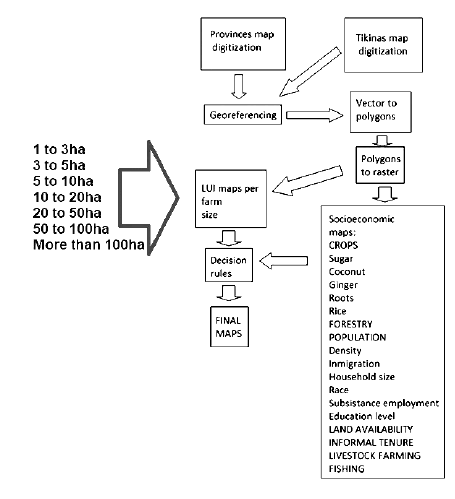
Figure 1. Policy, population and degradation cycle. With a limited amount of agricultural land available, and decreasing land yields, farmers use labour to keep land producing (IWMI 2015).